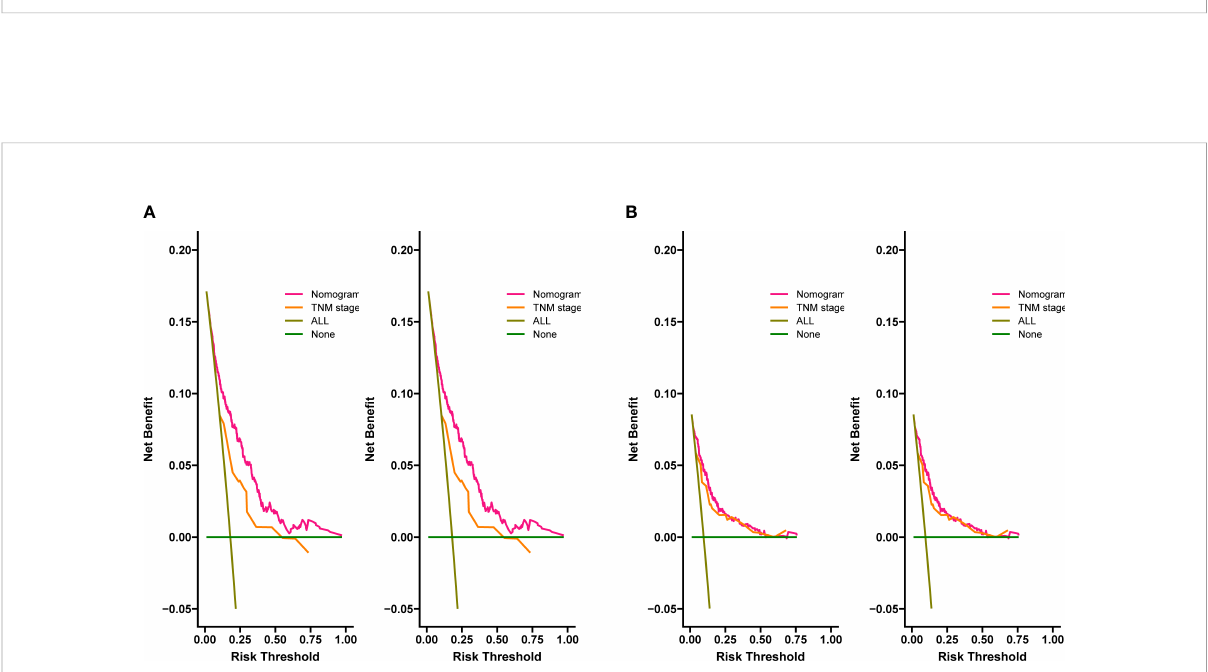
FIGURE 8 Decision curves of the nomogram predicting OS in external validation cohort (A) , the nomogram predicting CSS in external validation cohort (B)